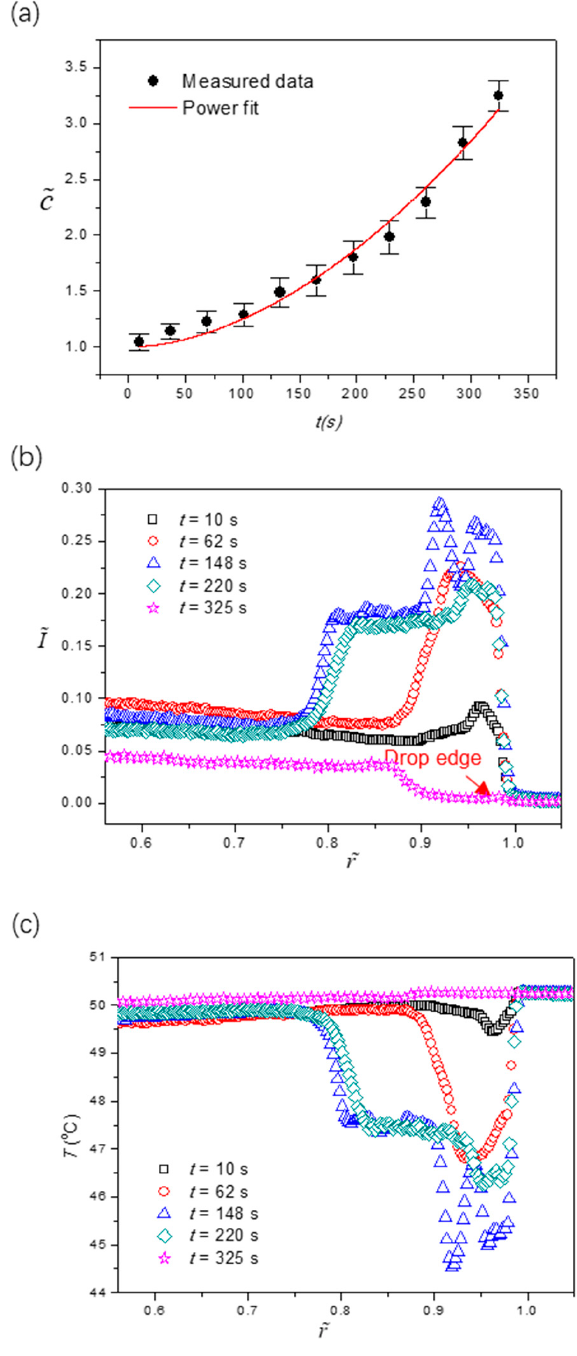
Figure 5. ( a ) global concentration enrichment of the fluorescent dye calculated based on the dynamic drop volume from Figure 4a; ( b ) profiles of the fluorescence intensity along the radial direction obtained from Figure 4b; ( c ) extracted temperature profiles along the radial direction at five different stages. The contact angle of the surface is θ 0 = 87.3 ± 0.2°.